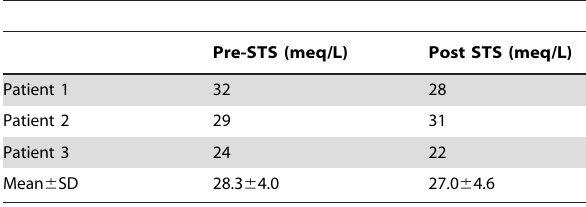
Table 2. Serum bicarbonate levels pre and post STS in hypercalciuric stone